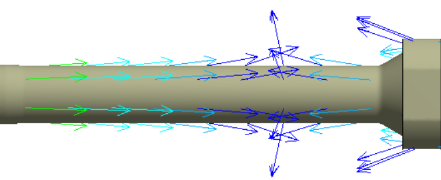
Figure 27. Results of the steady-state heat transfer analysis at 500 °C.